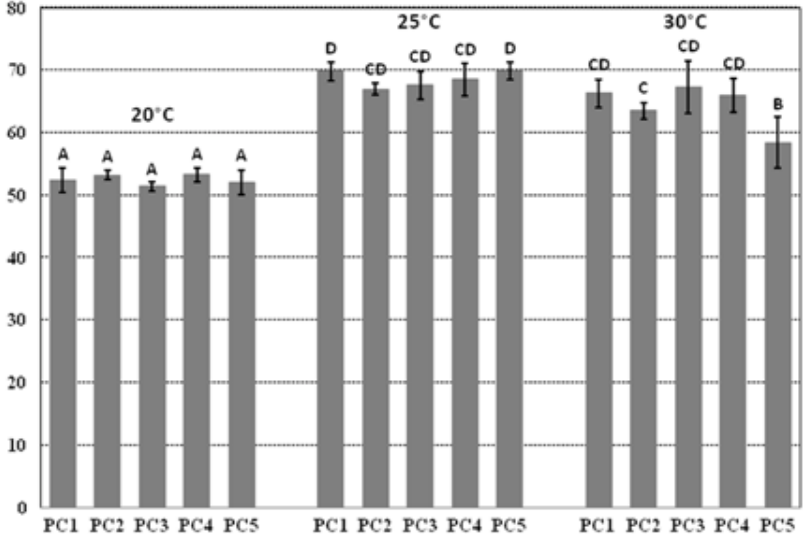
Figure 3. Average diameter growth (mm) of the Phytophthora cinnamomi isolates from plane tree, on PDA, after 8 days, at 20, 25 or 30°C in the dark. Growth rates of isolates marked by different letters (top of bar) are significantly different from each other (Bonferroni-corrected P <0.05); vertical bars indicate standard deviation of the